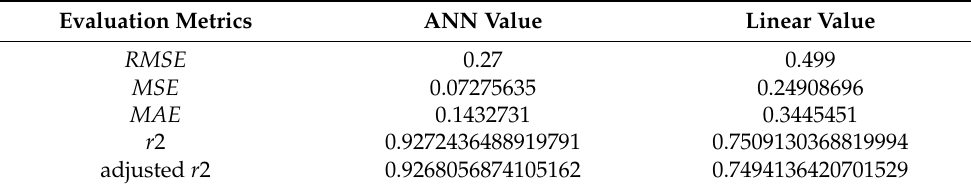
Table 5. Comparison of the evaluation metrics for the trained ANN model vs. linear regression model.